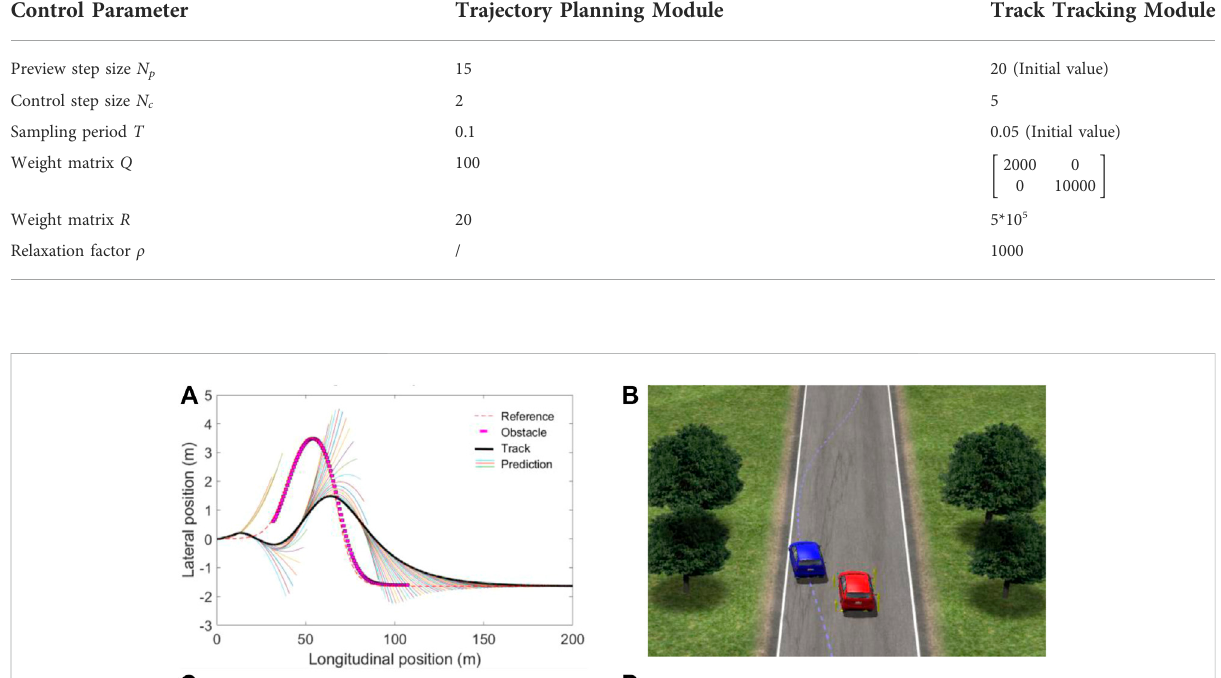
TABLE 1 Controller parameters.